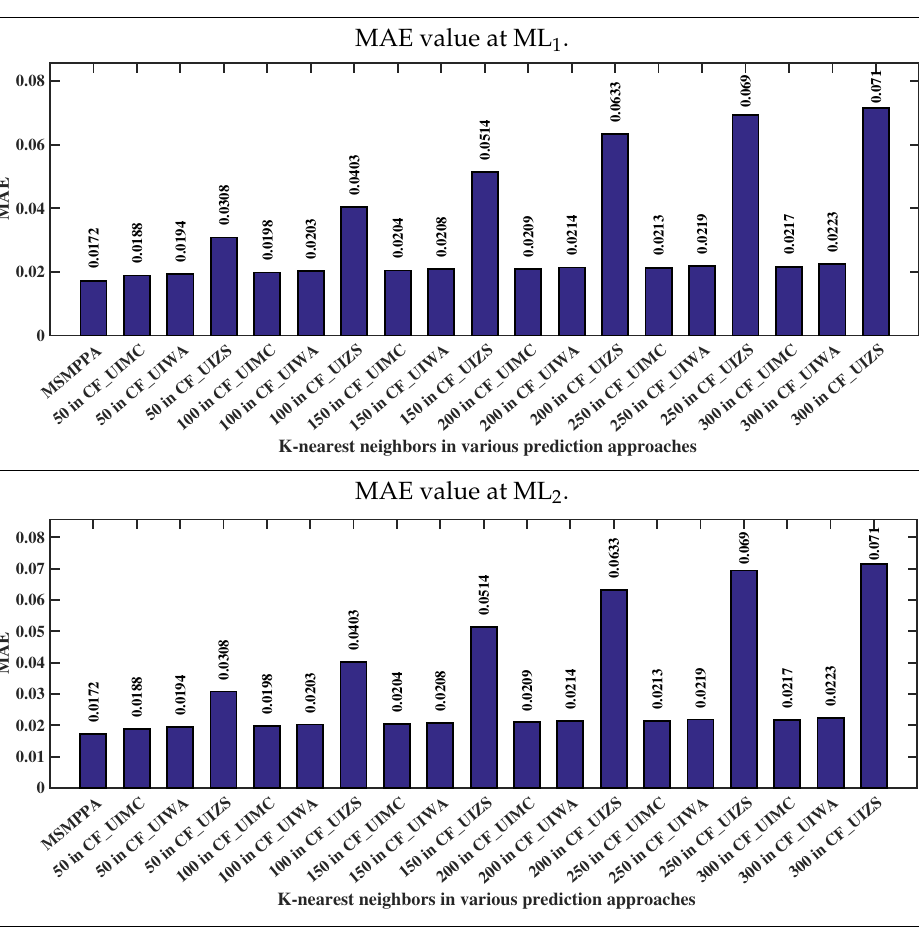
Figure 10. MAE Value at